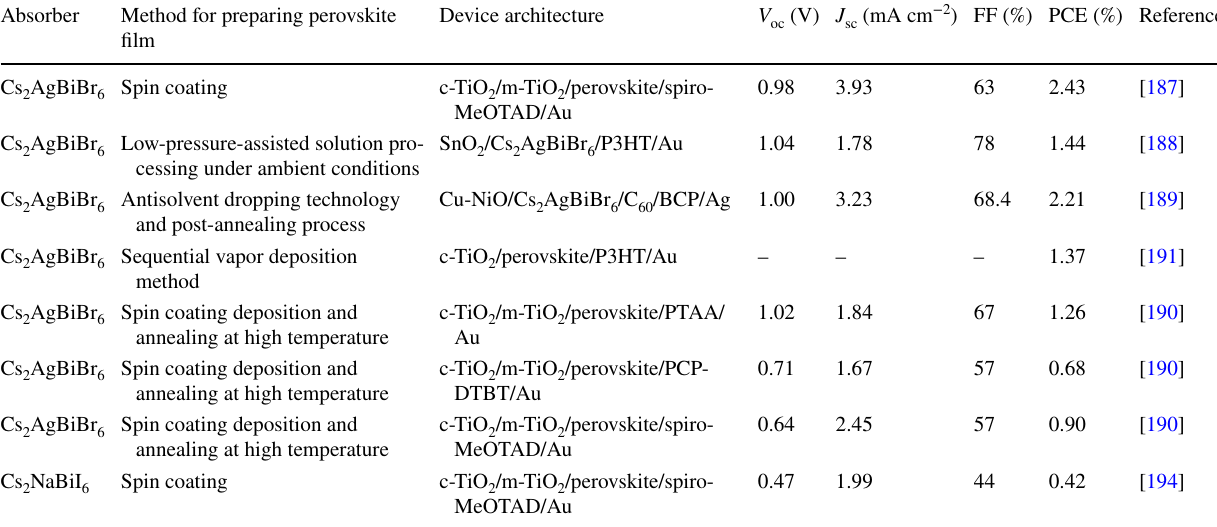
Table 3 Photovoltaic parameters of PSCs based on double perovskite A 2 B(I)B(III)X 6 absorbers Absorber Method for preparing perovskite